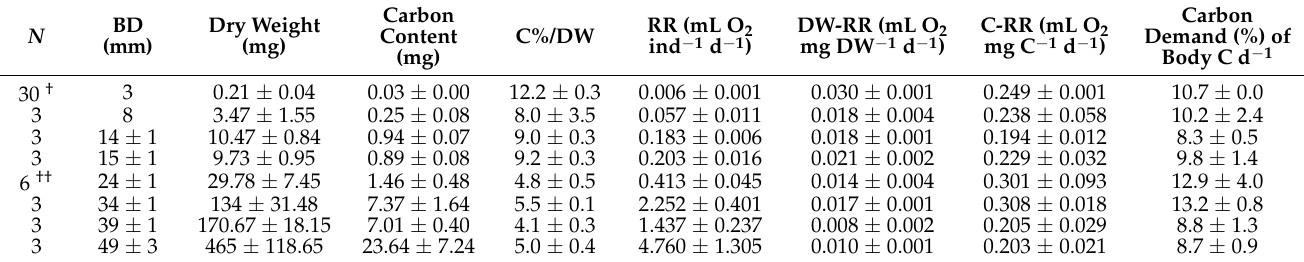
Table 4. Summary of the data used in the analyses. N = total number of individuals in each trial, DW = dry weight, C = carbon content, RR = respiration rate, DW-RR= dry-weight specific respiration rate, C-RR = carbon-specific respiration rate. † Only RRs were measured for these individuals. Values in bold, for ephyrae, were estimated by using regression equations of the rates calculated from other medusae. †† The presented RRs are half the measured RRs ( n = 2 in each experimental chamber).